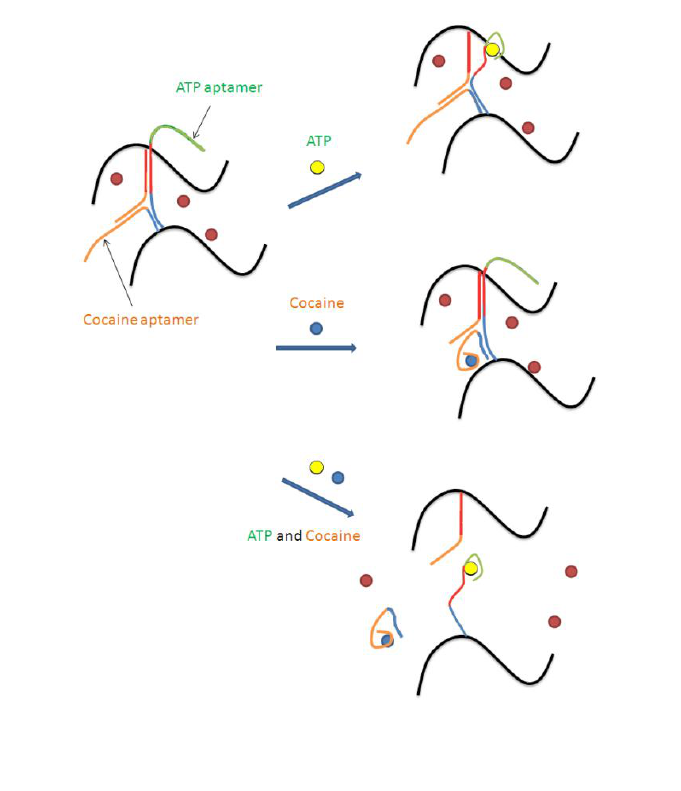
Figure 3. Logic “AND” gate using an aptamer-based smart material. A hydrogel is assembled using three components: two DNA-polymer conjugates and a crosslinker strand. One DNA-polymer conjugate is prepared from a sequence (blue-red-green) that contains the ATP aptamer (green) and is complementary to the other DNA-polymer conjugate (red) as well to the crosslinker (blue). The second DNA-polymer conjugate is prepared from a sequence (red-orange) that is complementary to the cocaine aptamer (orange) and complementary the other DNA-polymer conjugate (red). The crosslinking of these two polymer conjugates is further strengthened by a DNA sequence (orange-blue) that contains the cocaine aptamer (orange) and is complementary to the first DNA-polymer conjugate (blue). In the presence of either cocaine or ATP (top arrow and middle arrow) the hydrogel remains assembled. However, in the presence of cocaine and ATP (bottom arrow)